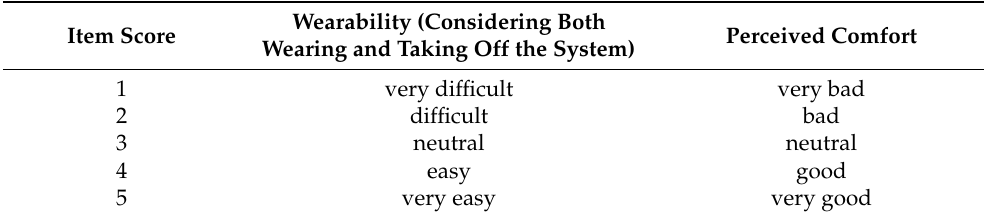
Table 5. Scoring table for the post-test questionnaire for the factors with their semantic meaning and the corresponding value of 1–5 in the Likert scale system.